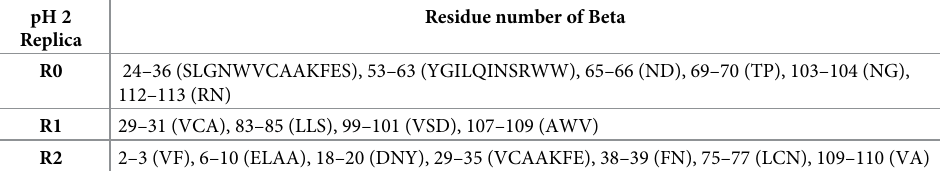
Table 3. Residue numbers and amino acid sequences of beta-strand found in the final structure of HEWL from all simulation replicas at pH